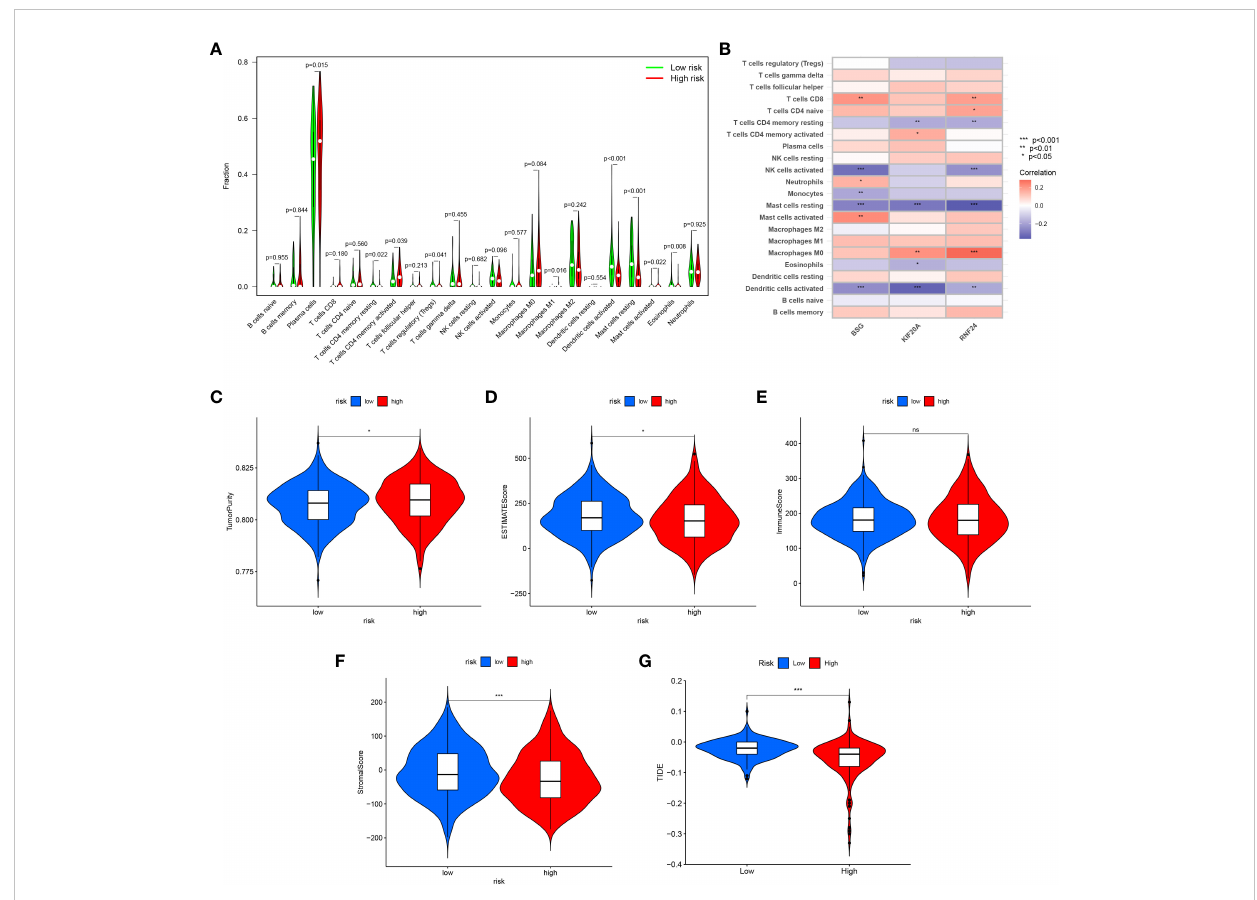
FIGURE 13 Immune in fi ltration and tumor microenvironment analysis between high-risk and low-risk groups. (A) The CIBERSORT algorithm was used to calculate the immune cell in fi ltration between the high and low risk groups. (B) The correlation between the signature genes and immune cells. (C) TumorPurity between the two risk groups. (D) ESTIMATEScore between the two risk groups. (E) ImmuneScore between the two risk groups. (F) StromalScore between the two risk groups. (G) Comparison of the scores of TIDE between the high and low risk group. *<0.05; ns, Not Signi fi